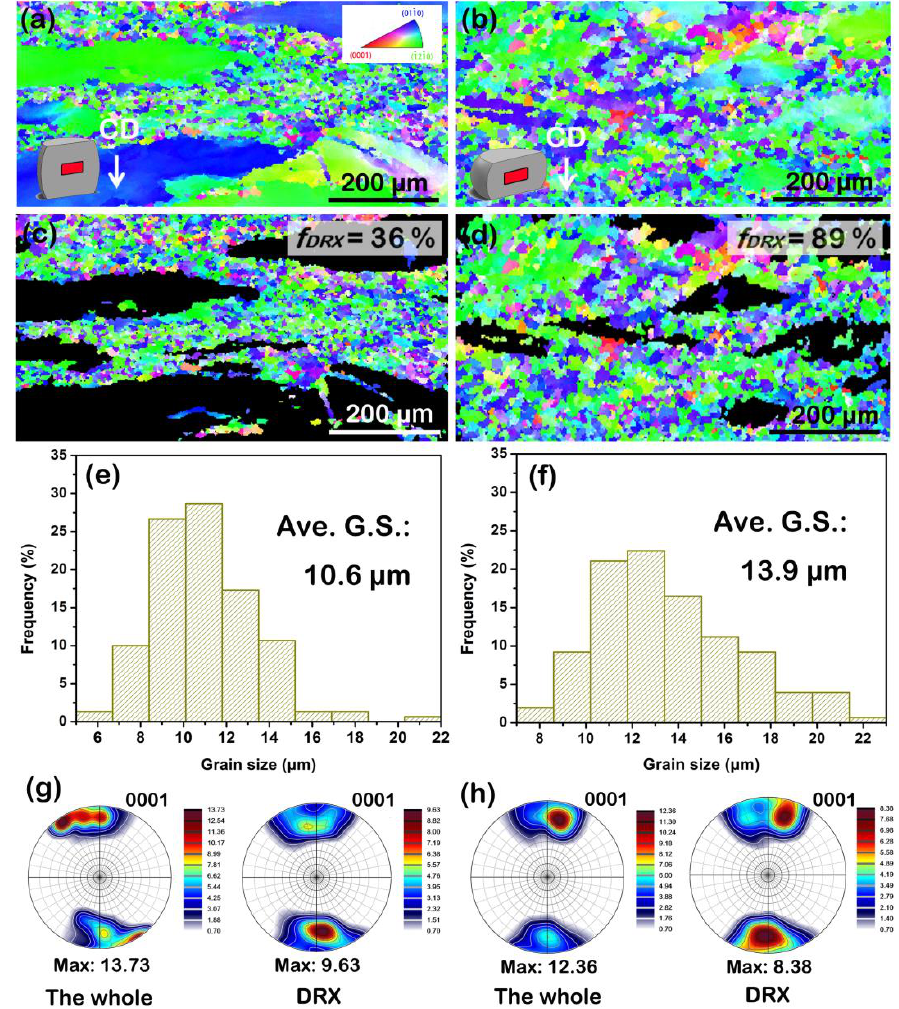
Figure 11. ( a , b ) EBSD images of the solution-treated BX31 alloy during the hot compressive strains of 0.3 and 0.5 at 623 K and 0.01 s − 1 , respectively. CD represents the compressive direction; ( c , d ) DRX regions selected from ( a ) and ( b ), respectively; ( e , f ) grain size distribution maps of DRX regions from ( c ) and ( d ), respectively; ( g , h ) (0001) pole figures containing the whole and DRX areas of the samples with 0.3 and 0.5 strains, respectively.